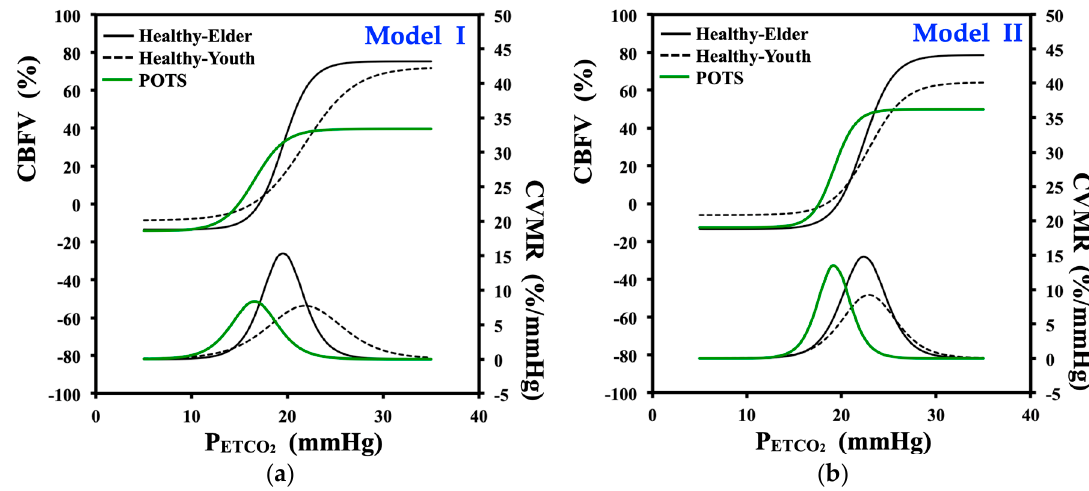
Figure 7. Nonlinear curve fit results of percentage change in CBFV responses to CO 2 (P ETCO 2 ) during hyperventilation for the three subject groups: ( a ) nonlinear regression with curve-fitting Model I of Equation (2); ( b ) nonlinear regression with Model II of Equation (3).